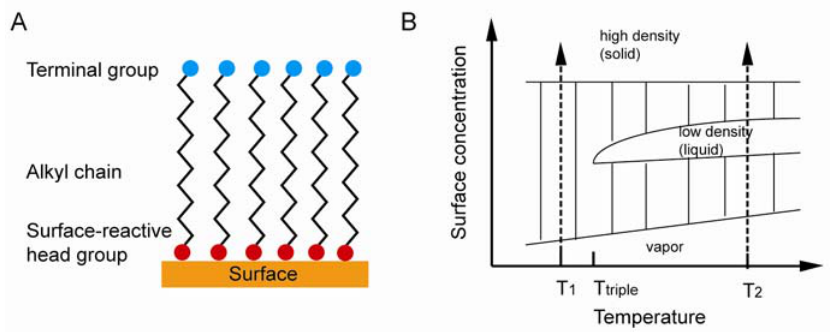
Figure 7. ( A ) Idealized SAM system (adapted from [64]), ( B ) Equilibrium phase diagram (adapted from